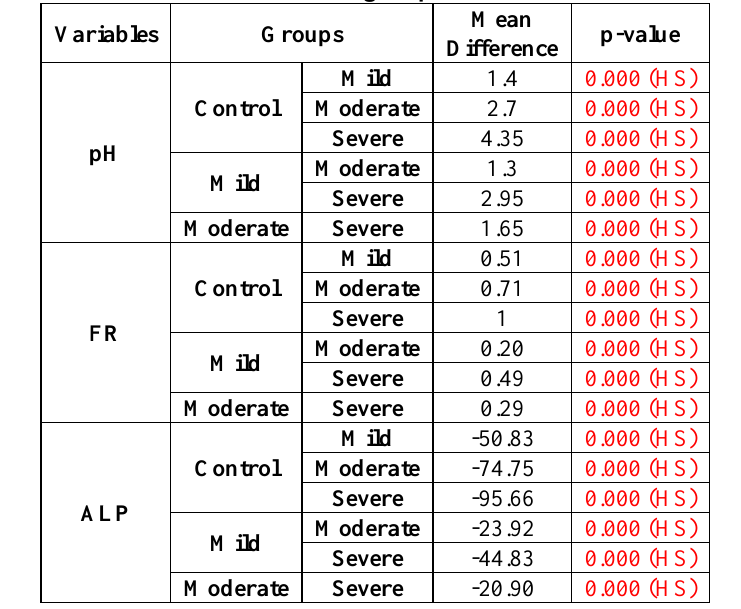
Table 4: Inter-groups comparisons of mean value of pH, FR, and ALP parameter between all